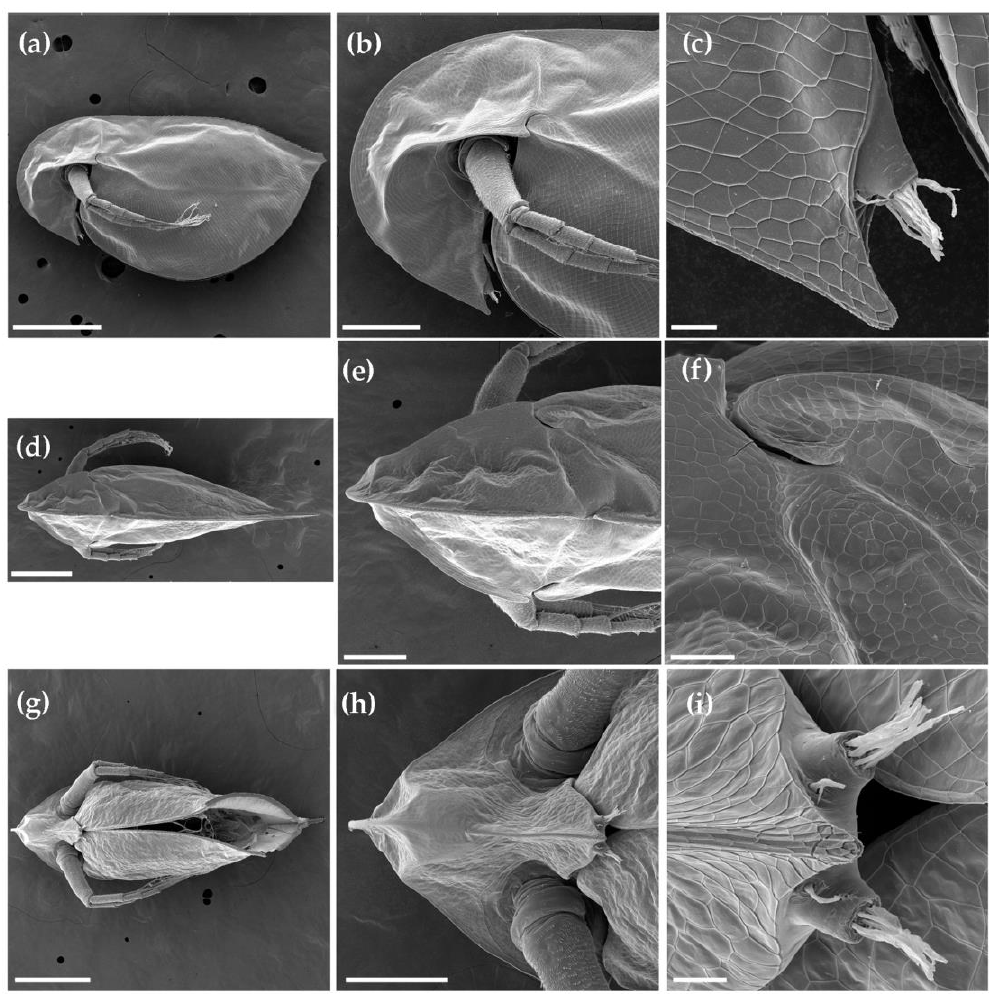
Figure 5. Daphnia arabica , adult parthenogenetic females from Al Shuwaib Dam, near Al Ain city, United Arab Emirates. ( a ) Female, lateral view; ( b ) head, lateral view; ( c ) rostrum and antenna I; ( d ) female, dorsal view; ( e ) head, dorsal view; ( f ) head, dorsal view on higher magnification; ( g ) female, dorsal view; ( h ) head, ventral view; ( i ) head, ventral view on higher magnification. Scale bars: 0.5 mm for ( a , d , g ), 0.2 mm for ( b , e , h ), 0.05 mm for ( f ), 0.02 mm for ( g , i ).